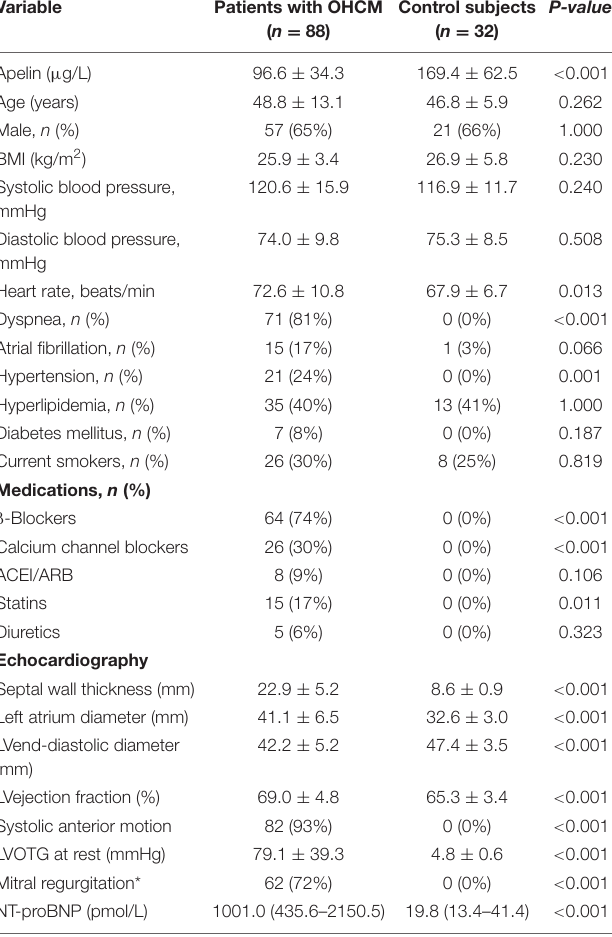
TABLE 1 | Baseline characteristics of patients with OHCM and control subjects. TABLE 2 | Characteristics of patients with obstructive hypertrophic cardiomyopathy according to plasma apelin levels stratified by mean